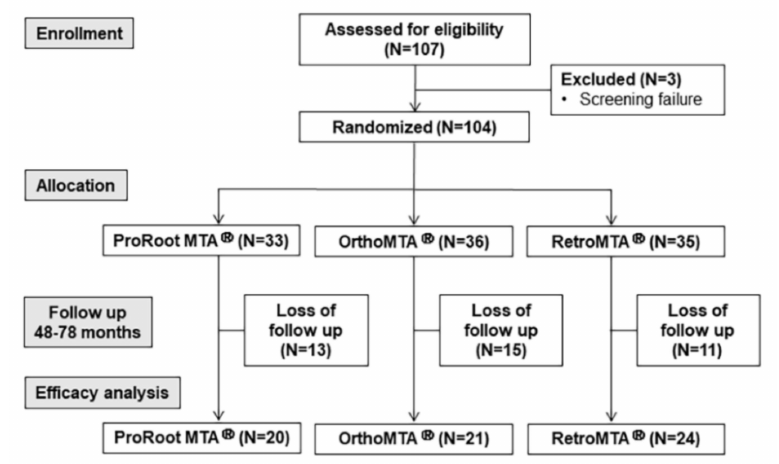
Figure 1. Patient flowchart of partial pulpotomy with three hydraulic silicate cements (HSCs) during a 48–78 months follow-up.